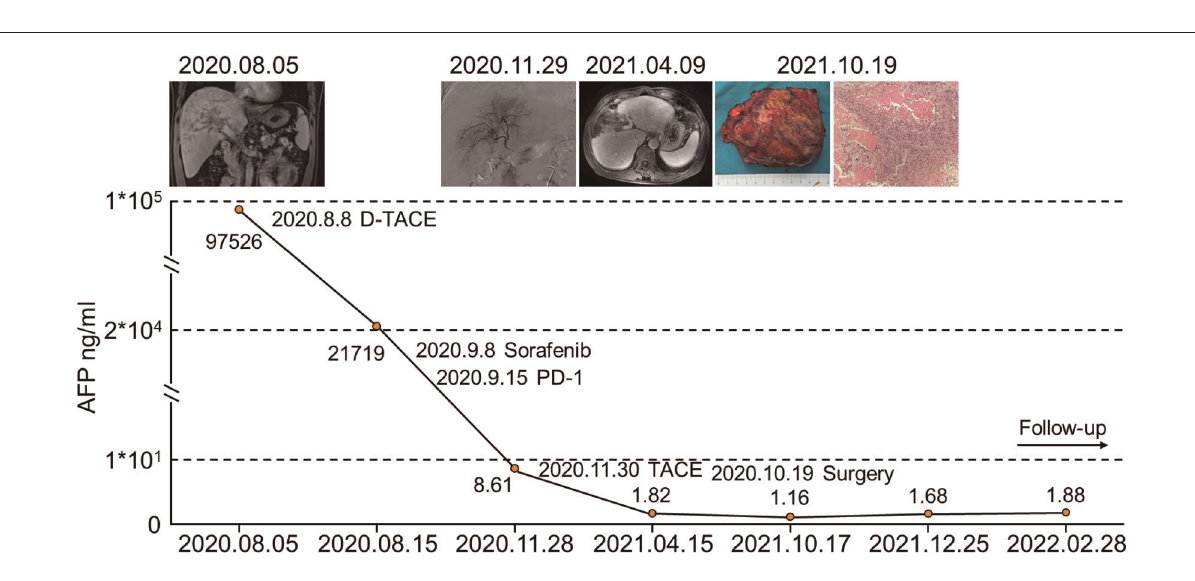
FIGURE 5 A successful case of conversion